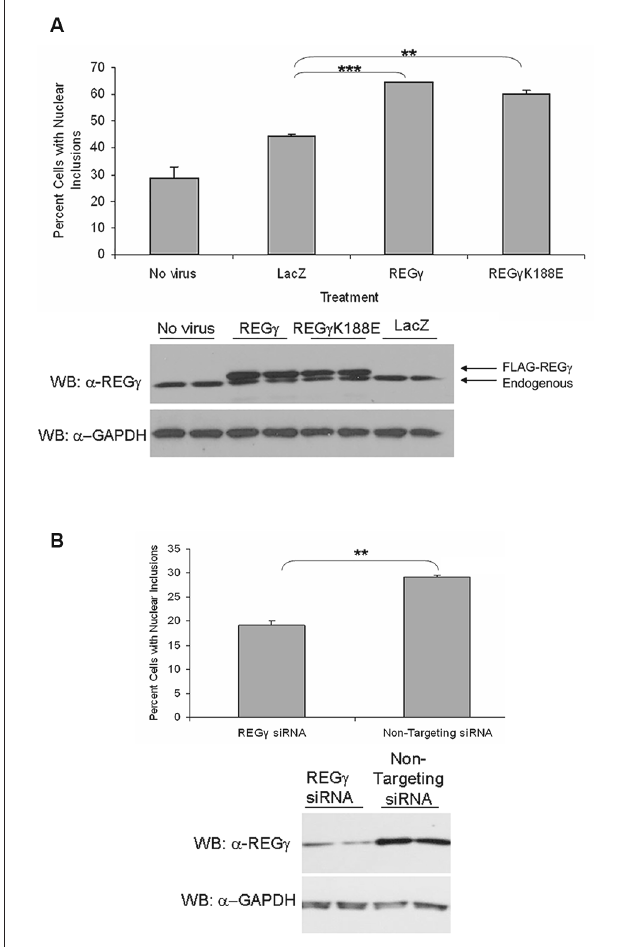
FIGURE 2 | Overexpression of REG γ and REG γ K188E significantly increases the percentage of cells with ARQ112 nuclear inclusion bodies whereas decreased expression reduces this percentage. (A) PC12 cells expressing ARQ112 were infected with adenovirus expressing FLAG-REG γ , FLAG-REG γ K188E or LacZ at multiplicity of infection 100 (MOI 100). Cells were then treated with Dox to induce AR in the presence of DHT for 72 h. Cells were immunostained with antibodies to the AR (N20), to FLAG for infectivity and stained with Hoechst to reveal nuclei. The percentage of cells with nuclear inclusions was calculated. Single factor analysis of variance (ANOVA) with post hoc Bonferroni-corrected t -test was performed. ∗∗ p < 0.01; ∗∗∗ p < 0.001. The above PC12 ARQ112 cells were also harvested at 72 h and evaluated for REG γ protein levels via Western blot analysis. Note the overexpression of FLAG-REG γ compared to endogenous protein levels. (B) PC12 ARQ112 cells were transfected with siRNA against REG γ or with a non-targeting siRNA control for 72 h. Cells were then induced with Dox and treated with DHT for 48 h. Cells were harvested after 120 h to evaluate REG γ protein levels via Western blot analysis. Densitometry showed 77% knockdown of REG γ protein. Cells were immunostained at 120 h with AR(N20) antibody and stained with Hoechst. The percentage of cells with nuclear inclusions was calculated. Student’s t -test was performed. ∗∗ p <